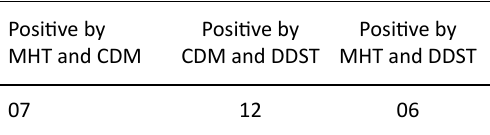
Table 6. Test results obtained by different combination of the test methods for MBL production